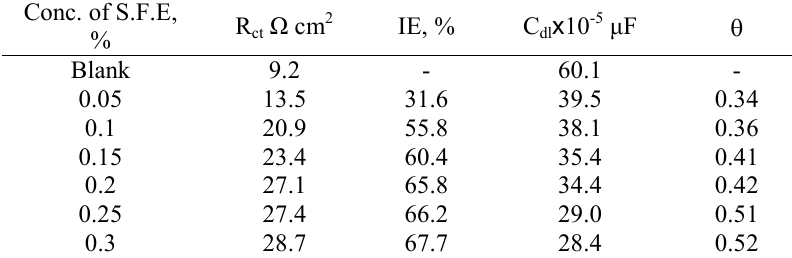
Figure 6. Impedance behavior of MS in the presence of SFCN extract Nyquist Plot. Table 4 . Impedance parameters of MS in the presence of SFCN extract in